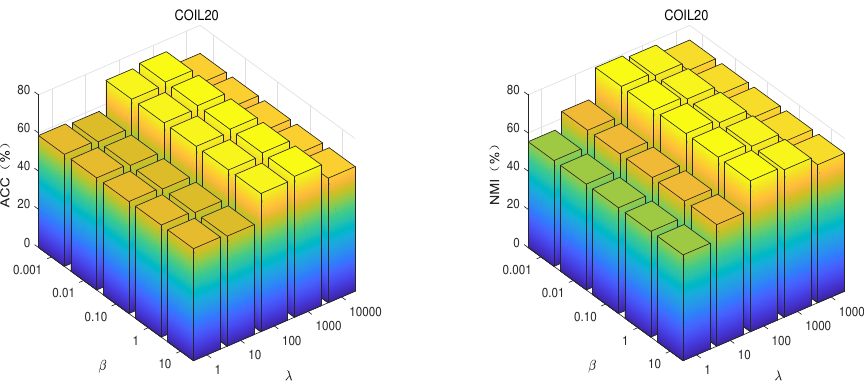
Figure 6. With fixed γ = 1 and β = 2, ACC and NMI of GSNMF-EMD with different α and λ and the same number of clusters on the COIL20 dataset.